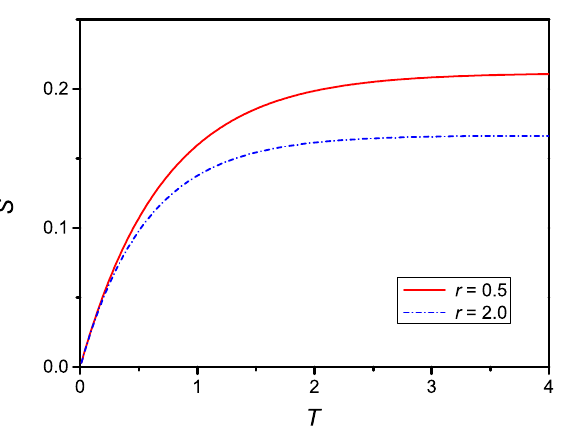
Figure 2. Dependence on the dimensionless surface density of adsorbed particles, S ( T ) , versus the dimensionless time, T , for u = 0.3, r = 0.5, (dash-dotted line) and r = 2, (full line).